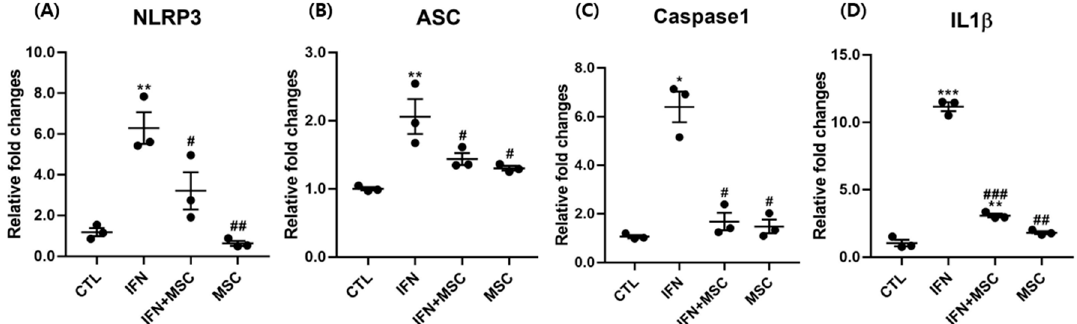
Figure 2. Analysis of gene expression by RT-PCR. The mRNA expression of ( A ) NLRP3, ( B ) ASC, ( C ) caspase-1, and ( D ) IL-1 β in hORSCs. The NLRP3 inflammasome components were increased in the IFN- γ -treated group and decreased in the MSCT group. Error bars represent the mean ± SEM, n = 3. Statistically significant at * p < 0.05, ** p < 0.01, and *** p < 0.001 compared to the control and # p < 0.05, ## p < 0.01, and ### p < 0.001, compared to the IFN- γ -treated group.